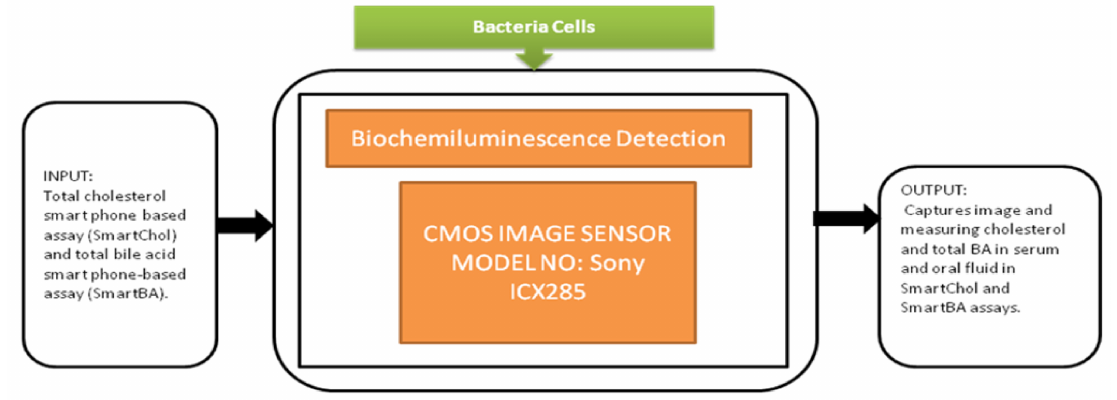
Figure 46. Biochemilunimescence